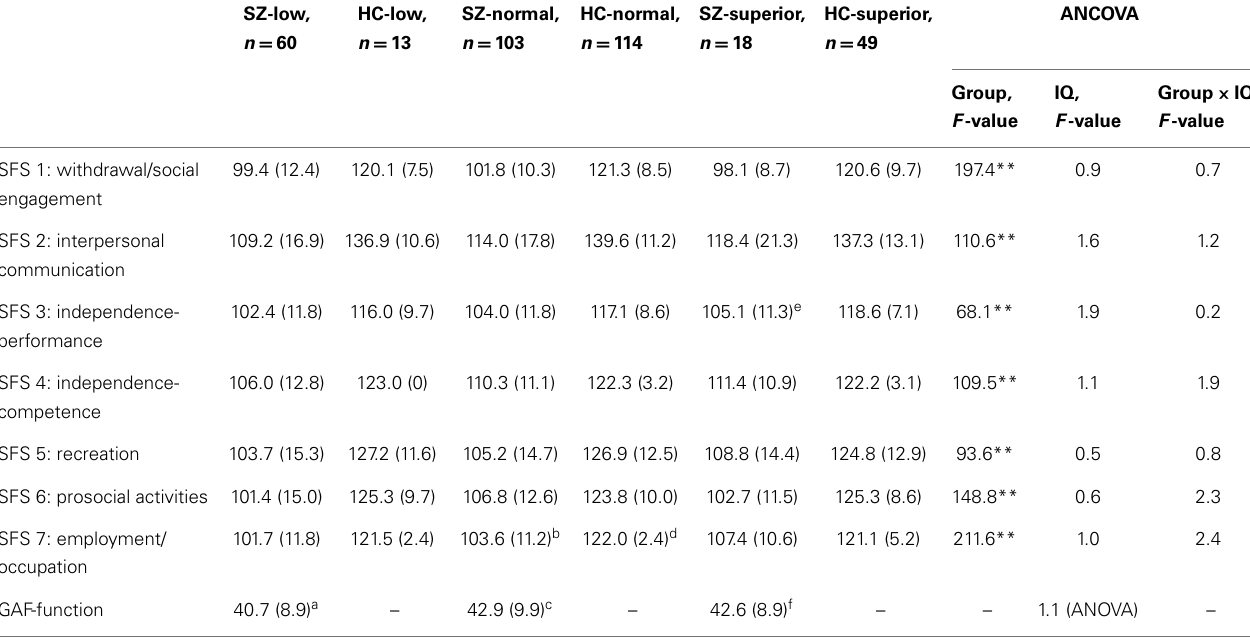
Table 4 | Social functioning in schizophrenia and healthy participant groups